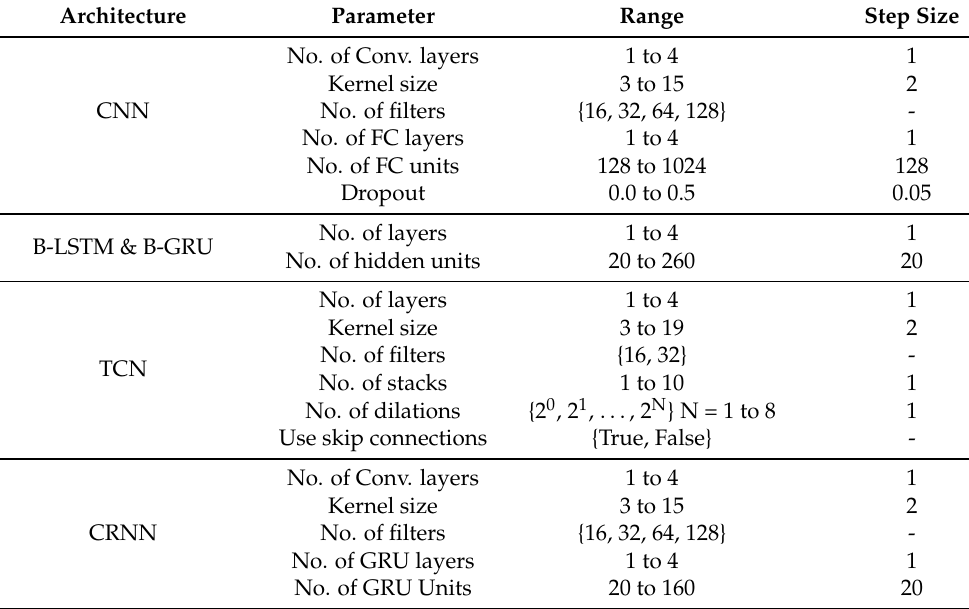
Table 1. The list of hyperparameters explored for each neural network architecture.